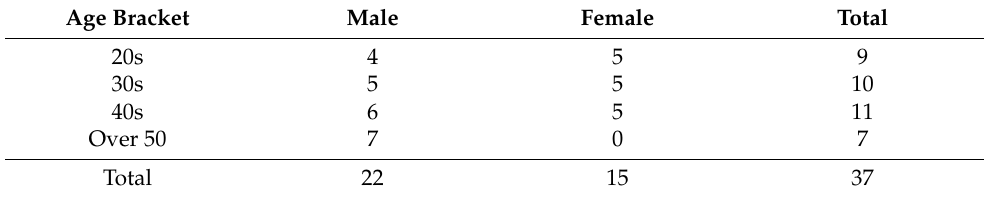
Table 2. Number of observers for each